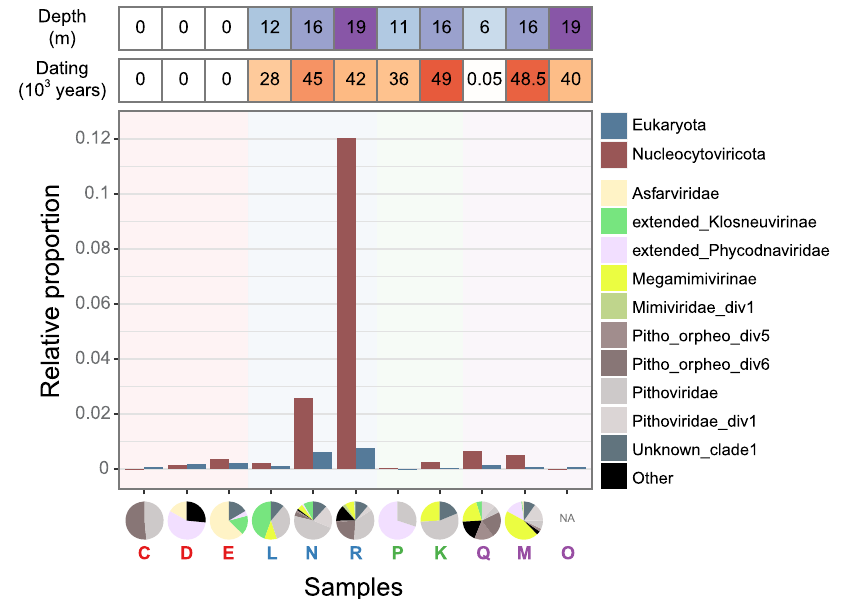
Fig. 2 | Relative abundance of Nucleocytoviricota and Eukaryota across sam- ples. The relative abundance is calculated as the sum of scaffold coverages belongingtothegivengroupdividedbythetotalsamplecoverageamongscaffolds ≥ 10kb.SamplenamesinredaresurfacesamplesfromKamchatkawhilesamplesin blue, green and purple indicate that they come from three different forages in the